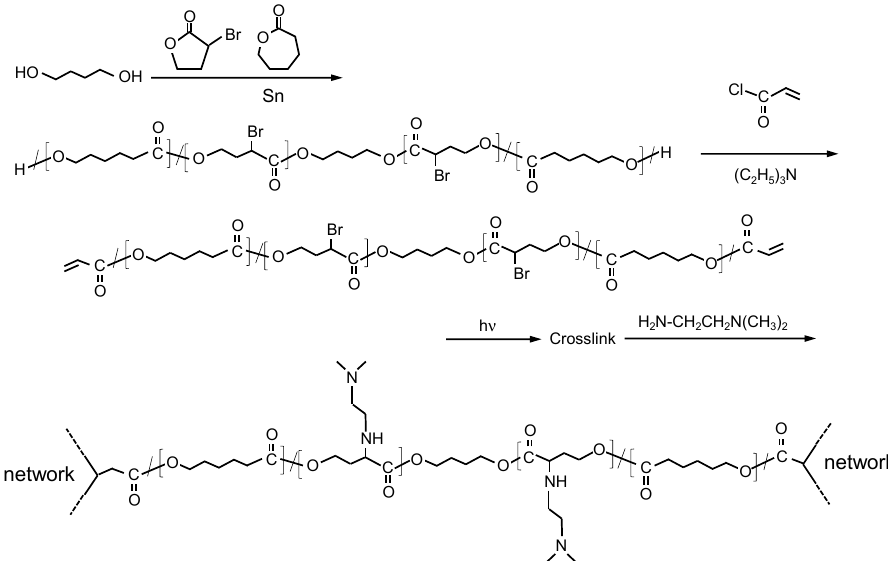
Figure 1. Preparative schemes of branched PolyCL-co-BrBL-OH, its macromonomer, and amine-modified crosslinked materials.